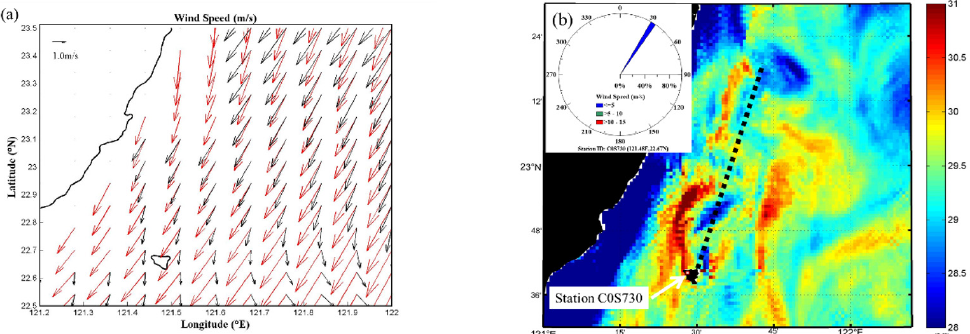
Figure 9. ( a ) Wind fields of the CWB-WRF (red arrows) and satellite ASCAT (black arrows) datasets as well as ( b ) numerical SST and velocity fields at 01:00 UTC on 9 September